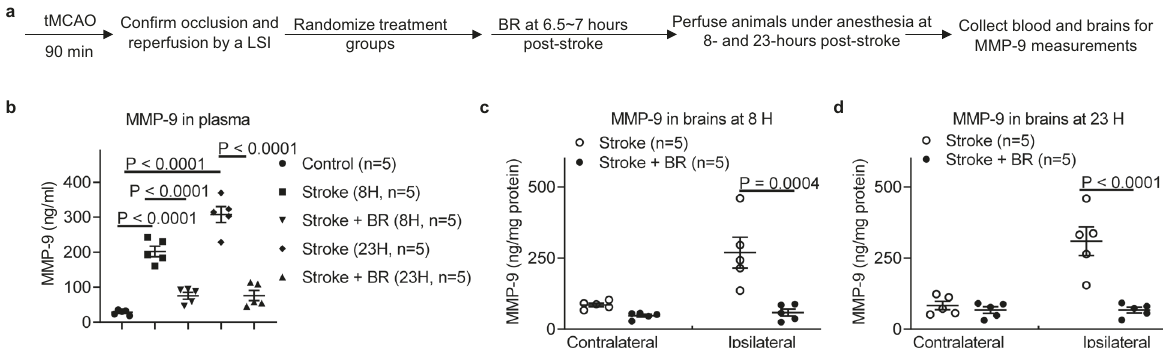
Fig. 7 Blood replacement therapy reduces levels of MMP-9 in the plasma and brains in stroke mice. a Experimental design. Mice (8~12-month-old males) underwent tMCAO for 90 min. The occlusion and reperfusion were con fi rmed by a laser speckle imager (LSI). Stroke mice were then randomized into two groups: a stroke only group and a blood replacement (BR) therapy group receiving 500 µ l of blood from healthy donors. Blood was replaced into stroke mice at 6.5~7 h post stroke. Brains were perfused and analyzed at 8 and 23 h after ischemia induction. b BR therapy reduced levels of MMP-9 in the plasma at 8 and 23 h post stroke. Control (circles, n = 5), stroke mice analyzed at 8 h post stroke (squares, n = 5), stroke mice with BR therapy analyzed at 8 h post stroke (down-pointing triangles, n = 5), stroke mice analyzed at 23 h post stroke (diamonds, n = 5), stroke mice with BR therapy analyzed at 23 h post stroke (up-pointing triangles, n = 5). The BR therapy reduced the levels of MMP-9 in ischemic hemispheres at c 8 and d 23 h post stroke. Data were presented as means ± SEM. One-way ANOVA followed by post hoc Tukey ’ s tests. Stroke mice group (white circles, n = 5); stroke mice with BR therapy group (black circles, n = 5). Source data are provided as a Source Data fi